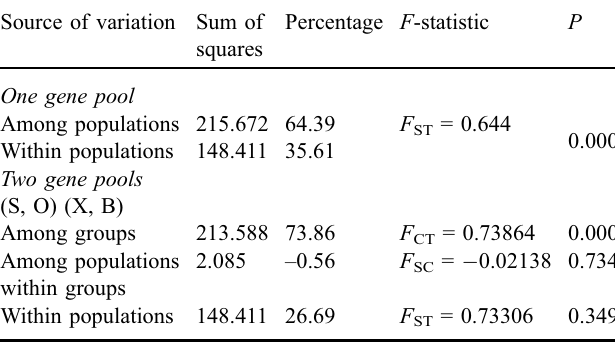
Table 3. Analysis of molecular variance (AMOVA) of P. chinensis populations based on mitochondrial control region sequences.